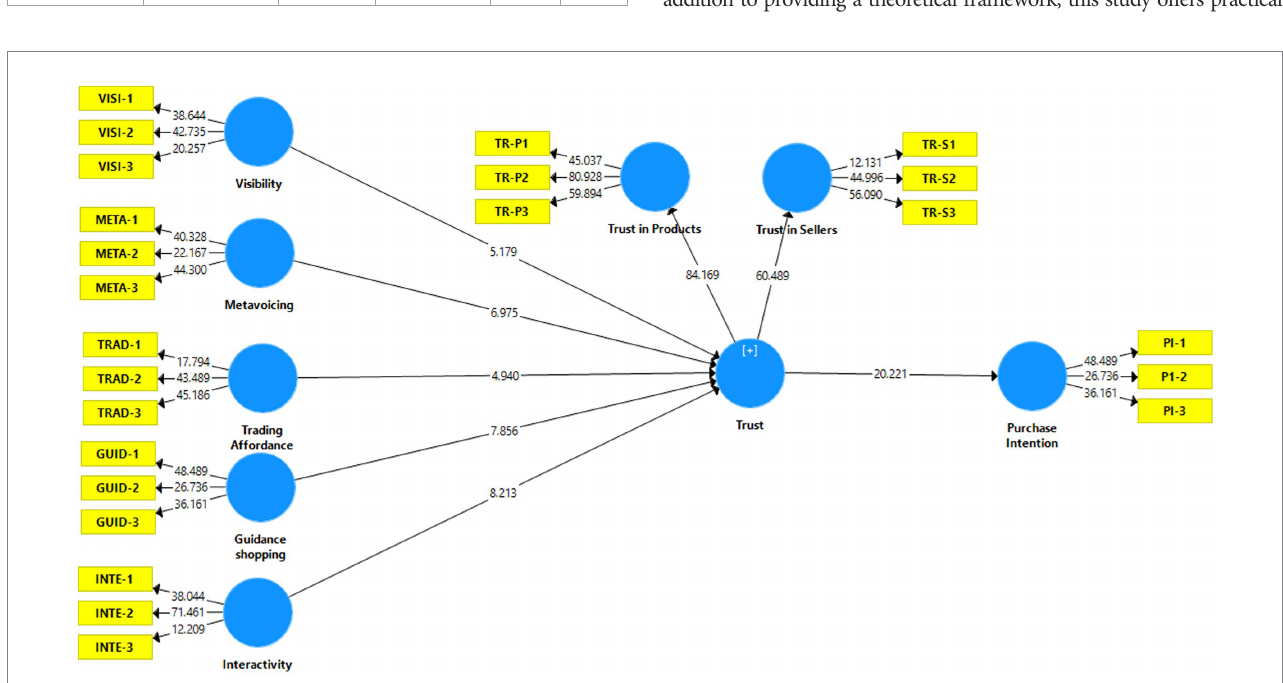
FIGURE 2 Structural model.